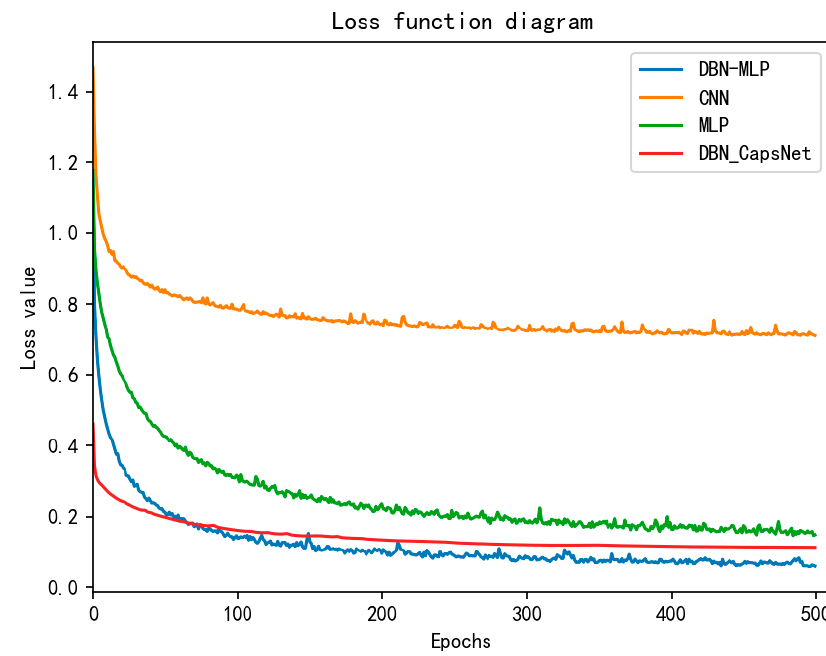
Figure 6. Cross-validation results.